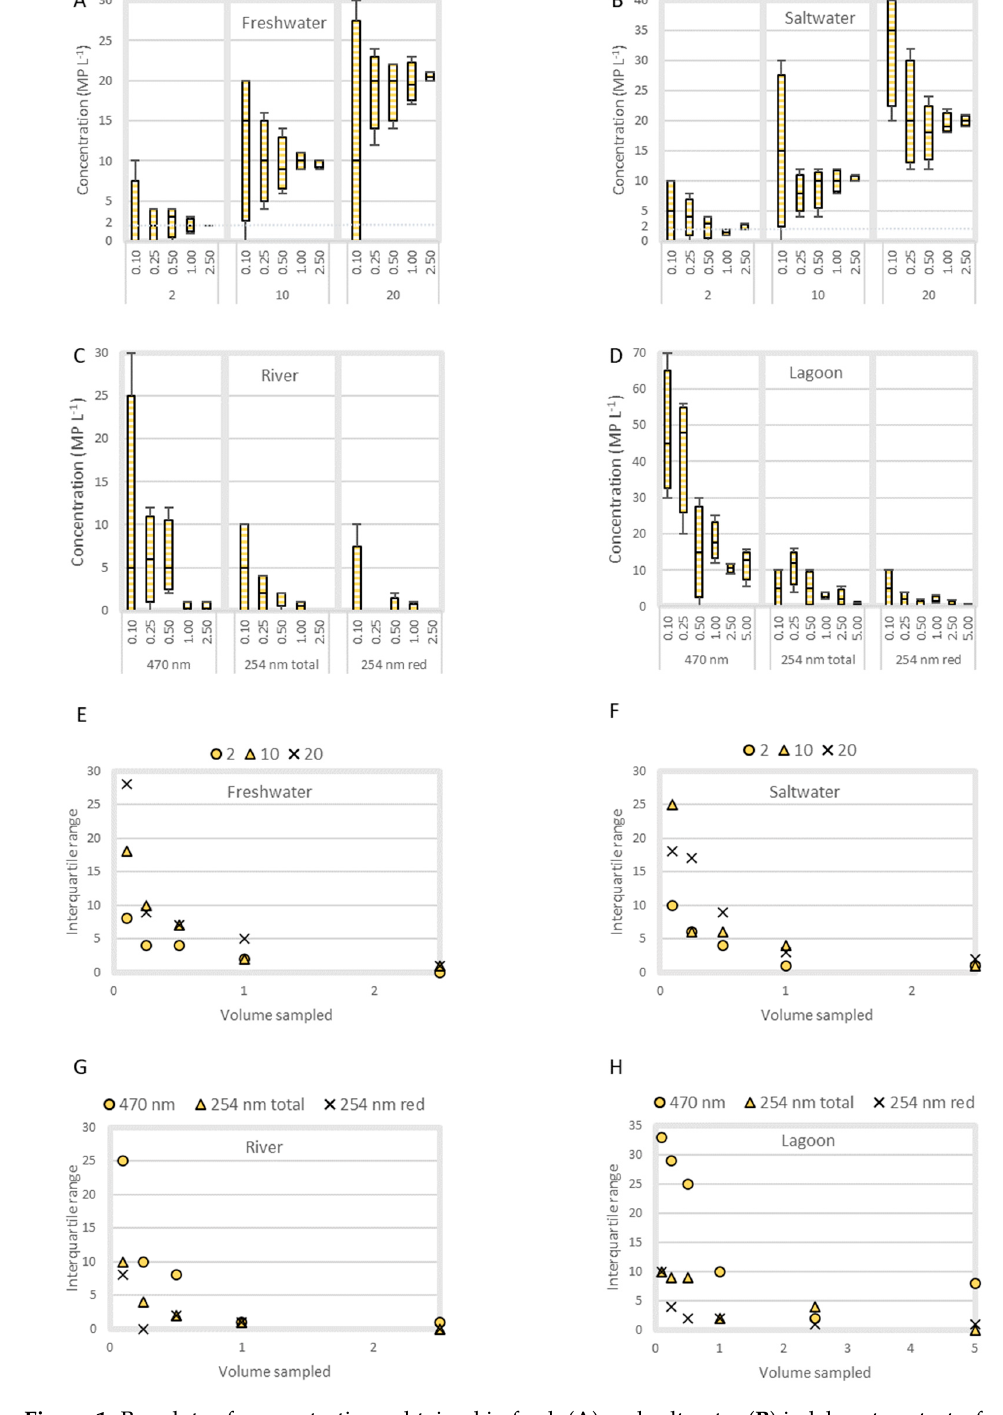
Figure 1. Boxplots of concentrations obtained in fresh ( A ) and saltwater ( B ) in laboratory tests, from spikes of 2 MP L − 1 , 10 MP L − 1 , and 20 MP L − 1 , and concentrations obtained in environmental sampling of the Vouga River ( C ) and Aveiro Lagoon ( D ), quantified after Nile Red staining under the wavelengths of 470 nm, 254 nm all particles, 254 nm red particles. Interquartile range of fresh ( E ) and saltwater ( F ), by spike concentration (2 MP L − 1 , 10 MP L − 1 , 20 MP L − 1 ), and of environmental samplings of the Vouga River ( G ) and Aveiro Lagoon ( H ) by quantification